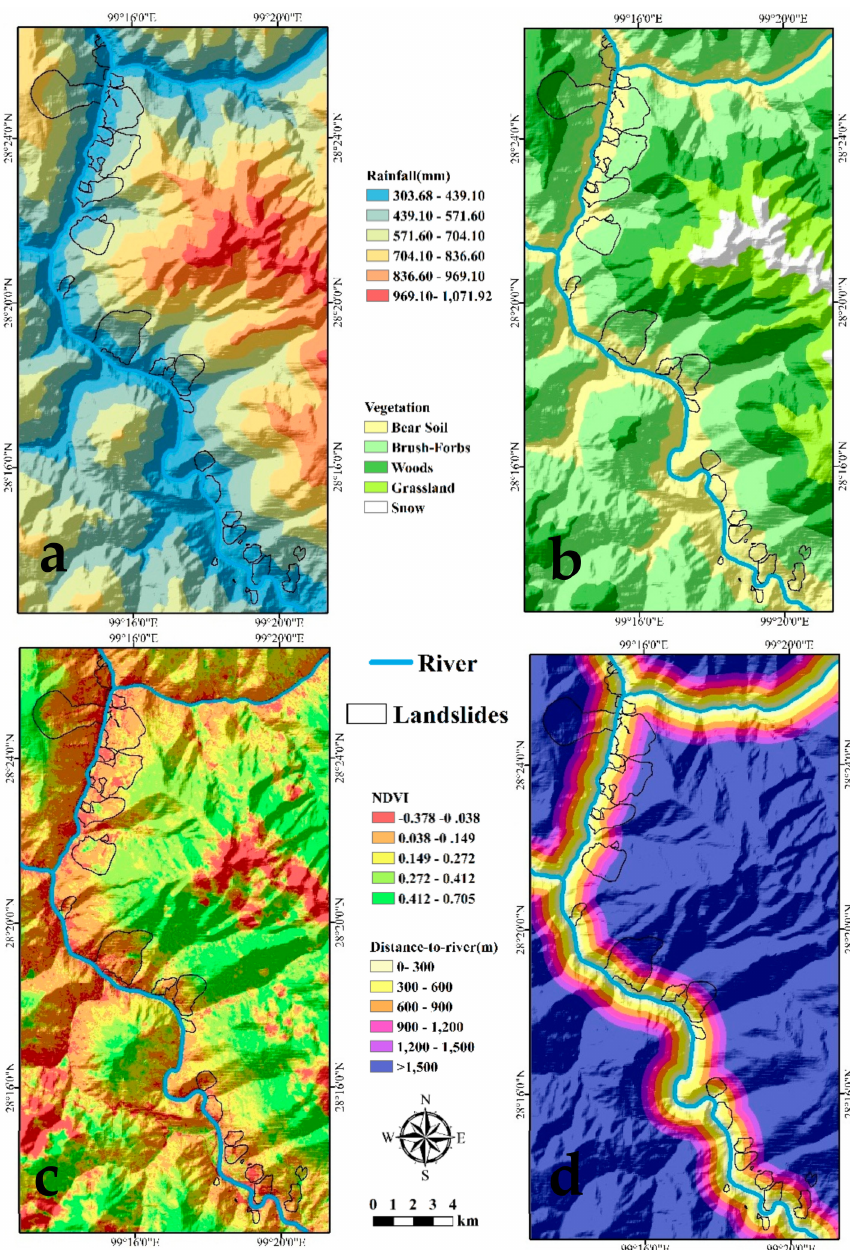
Figure 6. Influencing factor maps of the study area: ( a ) rainfall; ( b ) vegetation; ( c ) normalized difference vegetation index (NDVI); and ( d )